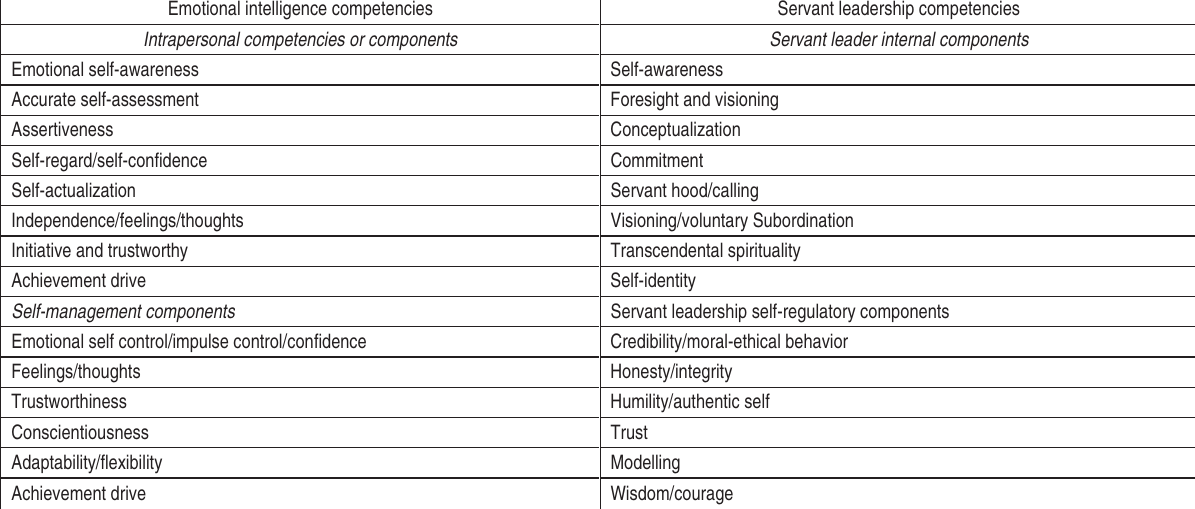
Table 1. Proposed integration of emotional intelligence and servant leadership skills Emotional intelligence